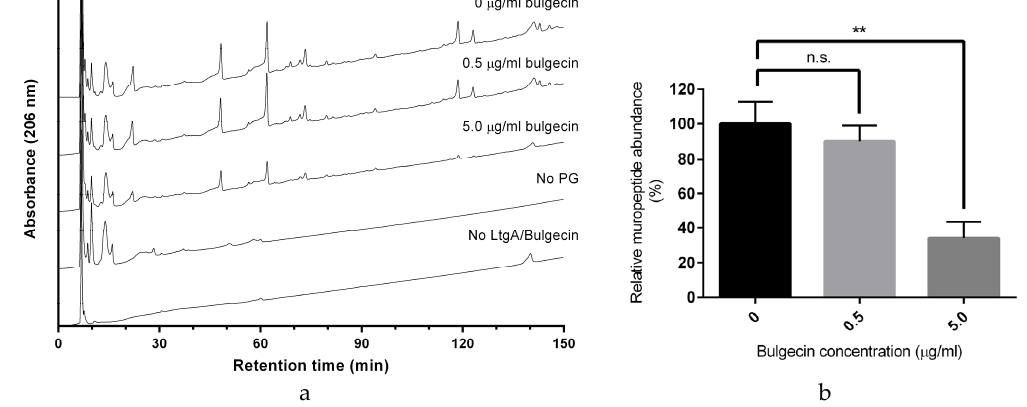
Figure 3. Inhibition of LtgA activity by Bulgecin A. ( a ) Reversed ‐ phase (RP) ‐ HPLC analysis of muropeptides released by LtgA digestion in the presence or absence of bulgecin A (0 μ M, 9 μ M, and 90 μ M); ( b ) Proportion of muropeptides released in the presence of bulgecin A relative to that released in the uninhibited reaction. ** p < 0.01 (unpaired t -test).